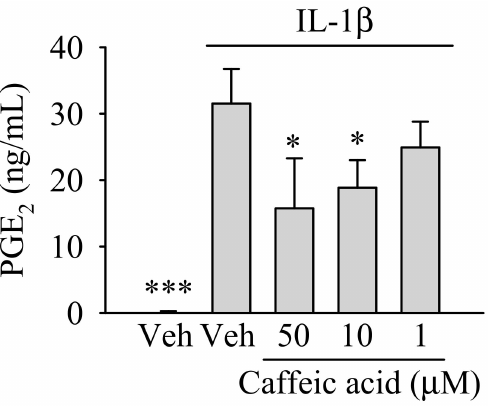
Figure 2. Dose-dependent effect of caffeic acid on the biosynthesis of prostaglandin E 2 (PGE 2 ) in IL-1 β -treated myofibroblasts of the colon, CCD-18Co. In the absence of caffeic acid, the cells were treated with 0.5% ( v / v ) DMSO in the presence or absence of IL-1 β (inflamed or control cells, respectively). The bar graph shows the data as the average ± standard deviation (SD) of three independent experiments ( n = 3). Each treatment was performed in triplicate. Significant differences are indicated in the figures as follows: * p < 0.05 and *** p <